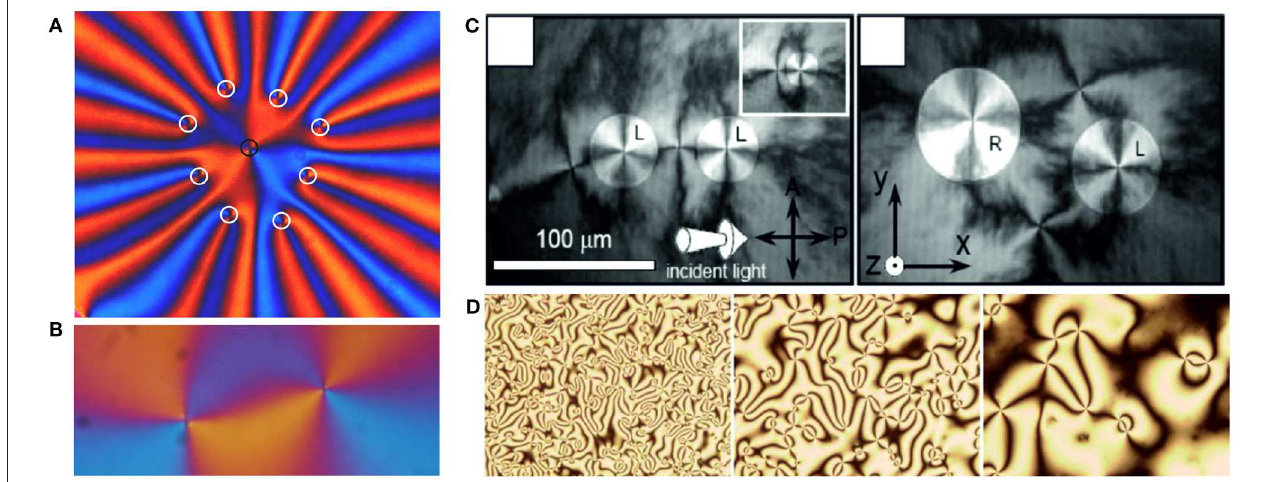
FIGURE 1 | (A) Snapshot of a non-equilibrium arrangement of nine defects in a SmC freely suspended film, all with topological strength other, and the pattern rapidly expands, with eight defects moving radially outward and one remaining in the center. The defect cores are labeled by small circles (see text). Figure adapted from Stannarius and Harth [32]. (B) Pair of two defects of opposite topological strengths, The defects attract each other and finally annihilate, leaving a defect-free uniform texture. Figure adapted from Missaoui et al. [43]. Both images were recorded with crossed polarizers and a diagonally inserted wave plate. (C) Depolarized reflected microscope images of islands in a SmC freely suspended film. The islands contain tangential clockwise (L) and counterclockwise (R) c-director fields and central Silvestre et al. [29] with permission, copyright American Physical Society. (D) Coarsening of umbilical defect patterns in a nematic cell with homeotropic anchoring and an electric field normal to the cell plane. The director of the material with negative 1ε is driven into the cell plane, forming numerous umbilic Reproduced with permission from Dierking et al. [44], copyright American Physical